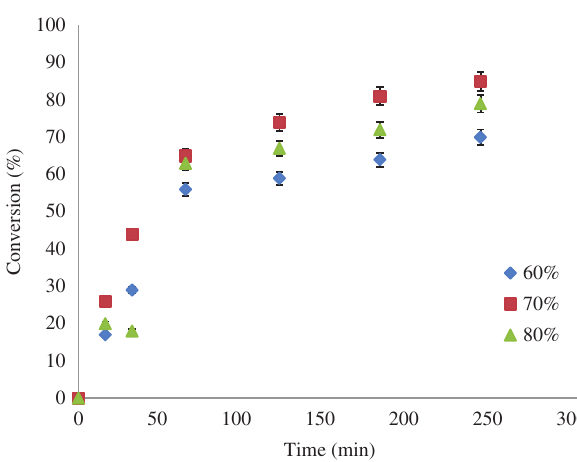
Figure 6: Effect of agitation speed on conversion at hexanol:triacetin ratio 1:1, hexane-3 ml, enzyme loading 4% (w/v), temperature 50 ° C, power 60 W, duty cycle 70% and frequency 25